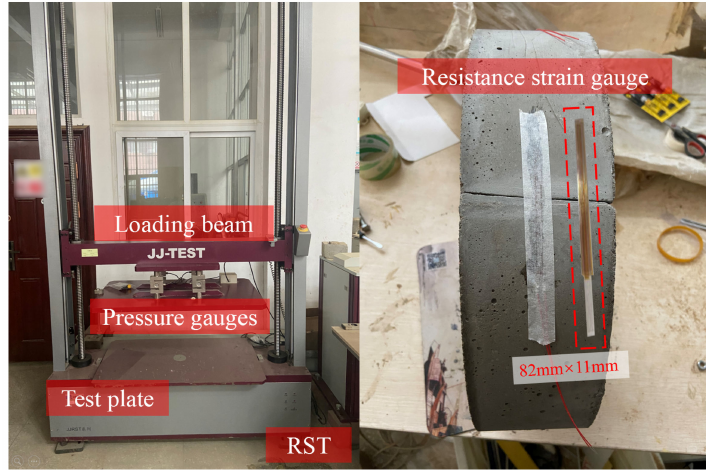
Figure 5. RST and resistance strain gauge used in